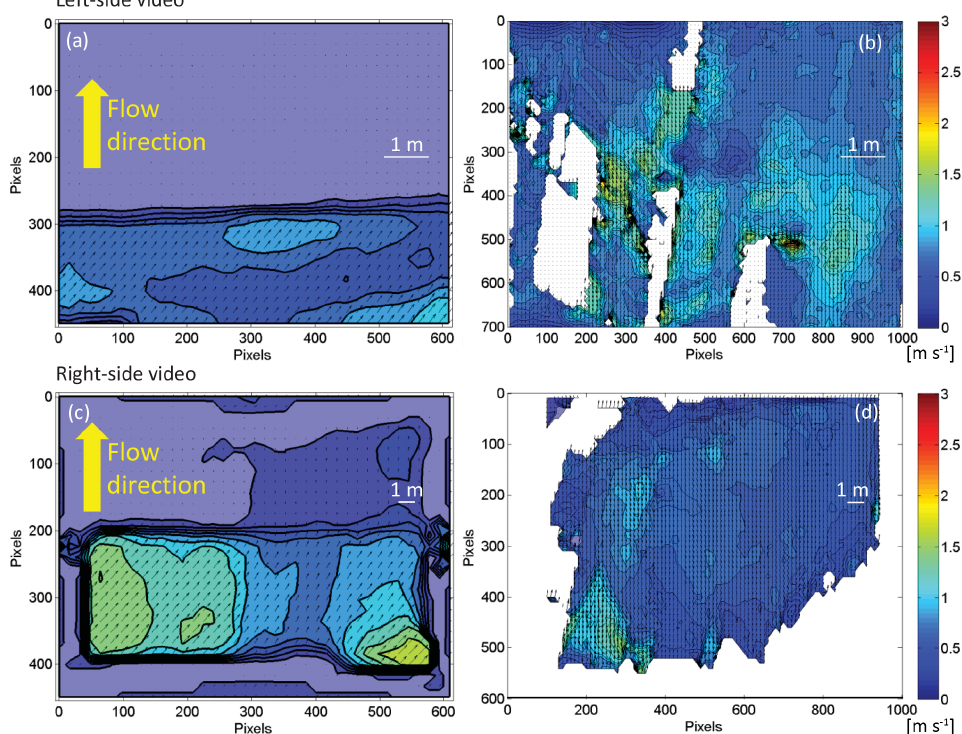
Figure 5. Experimental findings for the video captured at 07:50LT on 2 January: (a) LSPIV time-averaged map, (b) PTV time-averaged map for the left-side video, (c) LSPIV time-averaged map, and (d) PTV time-averaged map for the right-side video. Image resolution is decreased from 1024 × 768pixels to 640 × 480pixels for LSPIV processing. White areas in panels (b) and (d) are due to the absence of detected and tracked particles. Black arrows depict velocity vectors. Vectors in panels (a) and (c) are magnified by a factor of 2 to improve